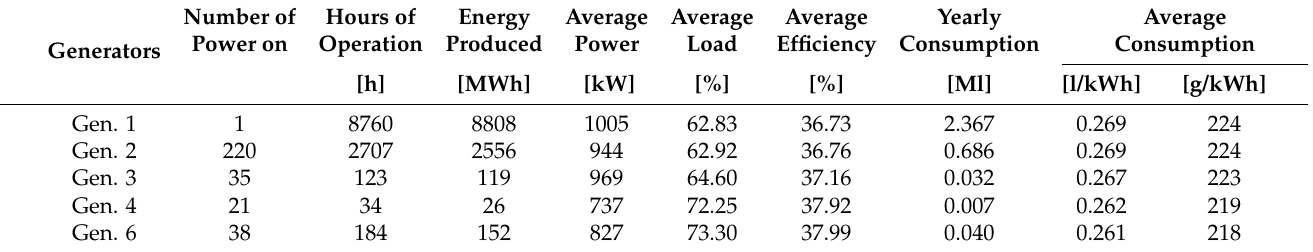
Table 16. Annual operating data of the generators on the typical year with BESS envisaged by 100% objectives of the Decree.